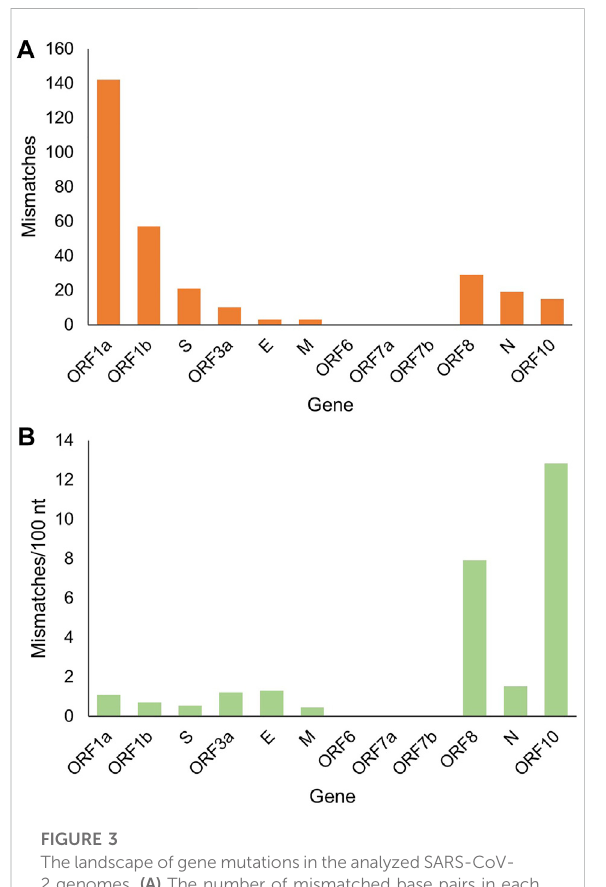
The landscape ofgene mutations intheanalyzed SARS-CoV- 2 genomes. (A) The number of mismatched base pairs in each gene. (B) Mismatch rate in each